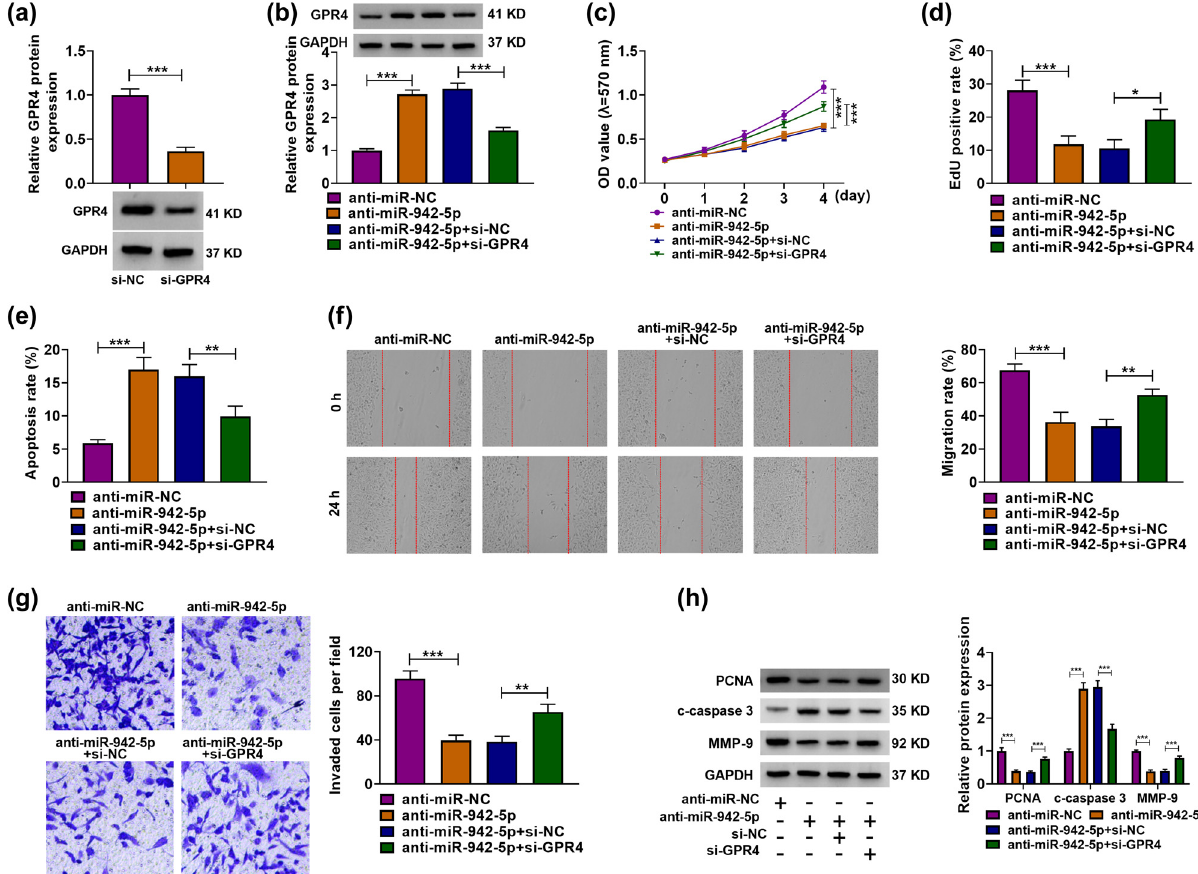
Figure 6: E ff ects between miR - 942 - 5p inhibitors and GPR4 knockdown on the proliferation, migration, invasion, and apoptosis of HTR - 8/ SVneo cells. ( a ) Knockdown e ffi ciency of GPR4 was determined by western blot in HTR - 8/SVneo cells. ( b – h ) HTR - 8/SVneo cells were transfected with anti - miR - NC, anti - miR - 942 - 5p, anti - miR - 942 - 5p + si - NC, or anti - miR - 942 - 5p + si - GPR4, and protein expression of